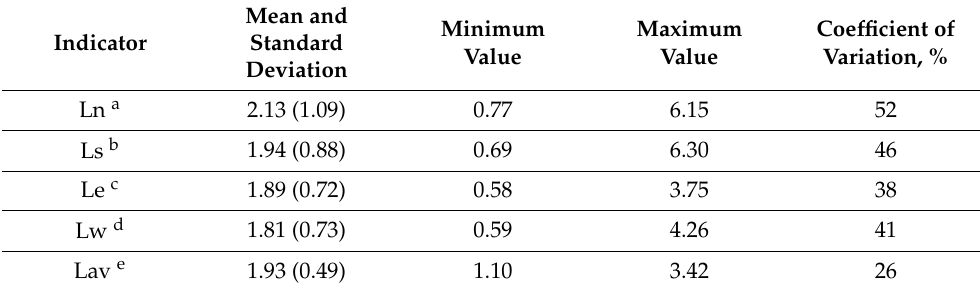
Table 3. Basic statistical indicators are used to group data by class in determining the influence of the factor of spatial structure